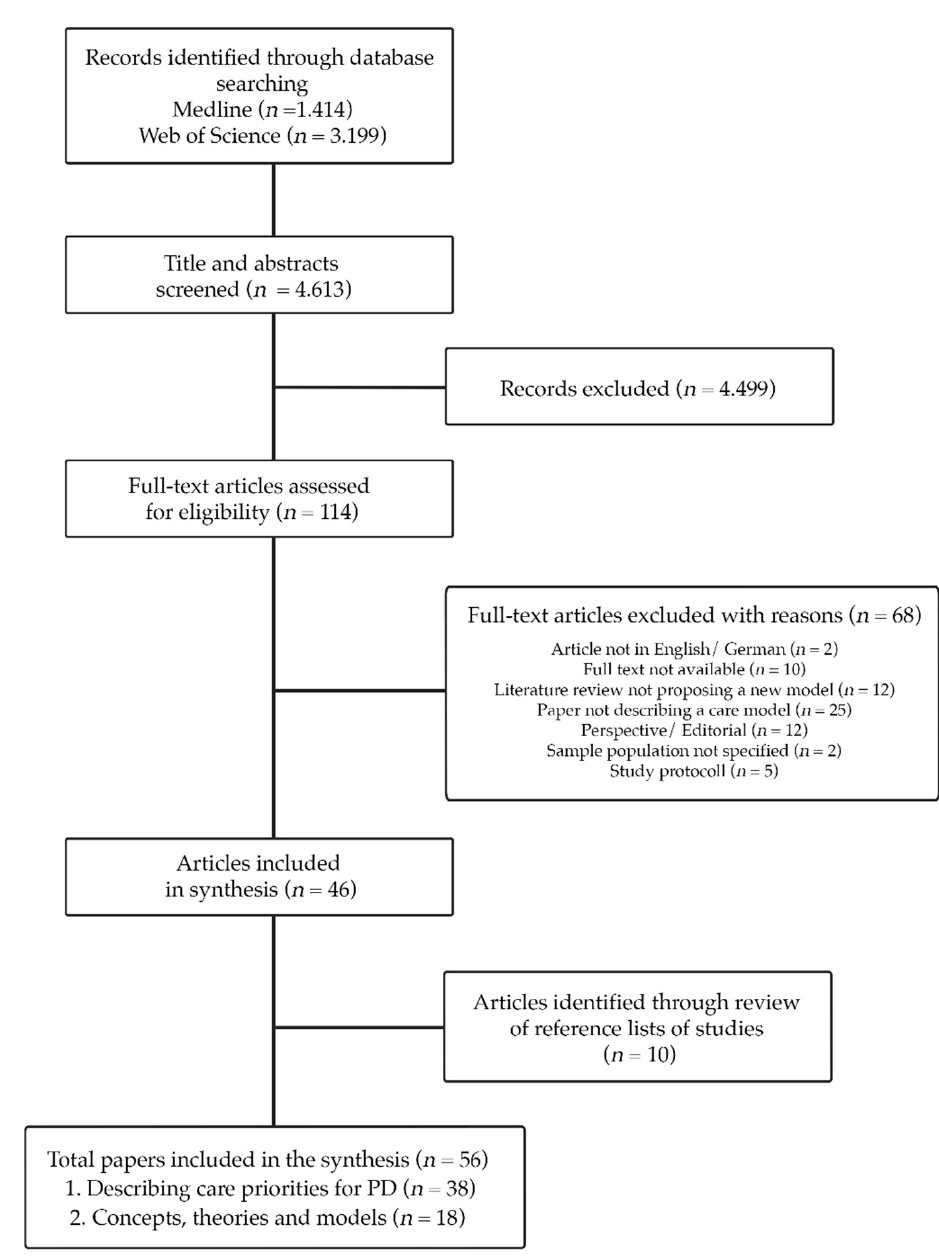
Figure 1. PRISMA flow diagram for the conducted scoping review.